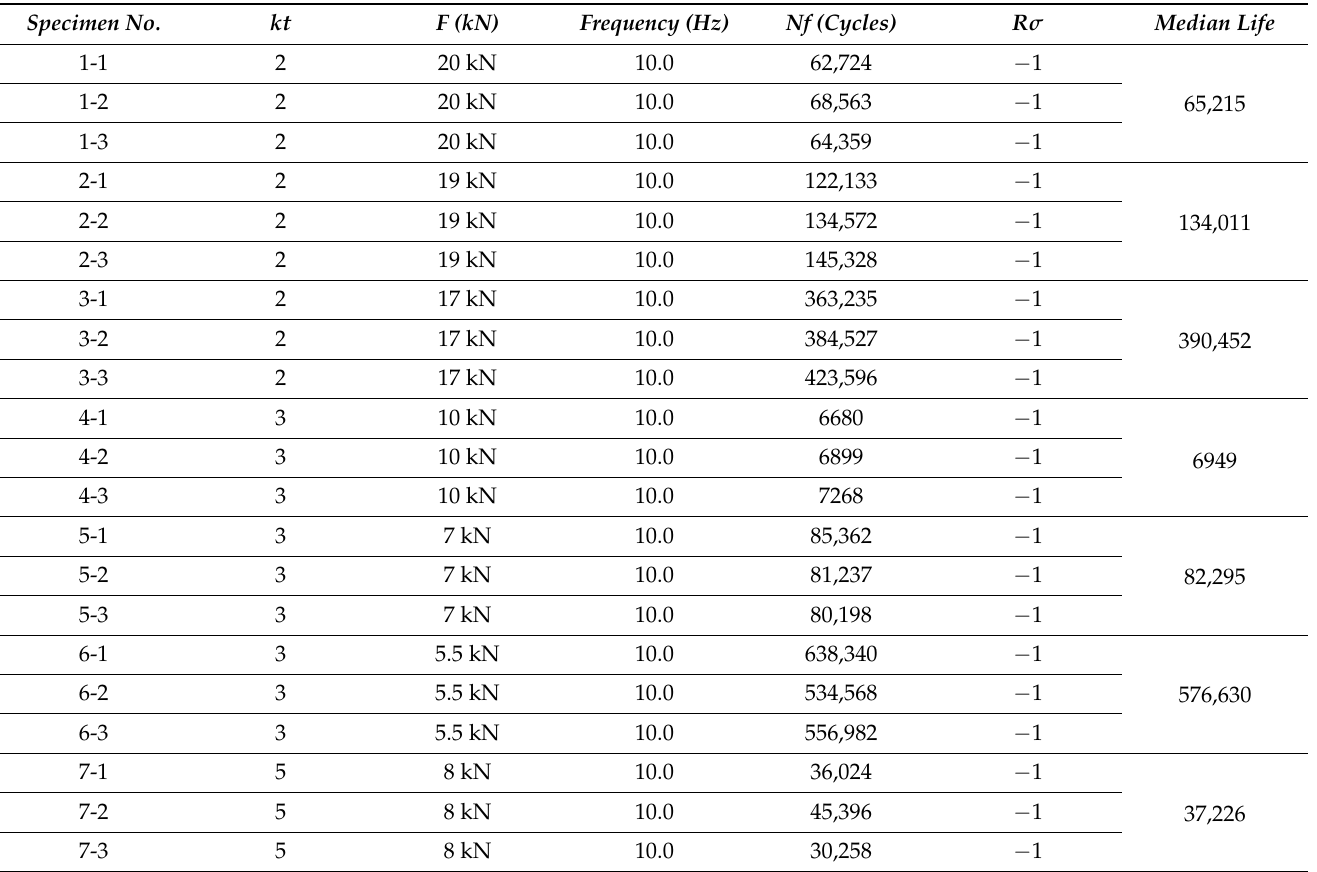
Table 5. Cyclic loading parameters and results of fatigue test for 40CrNi 2 MoV notched